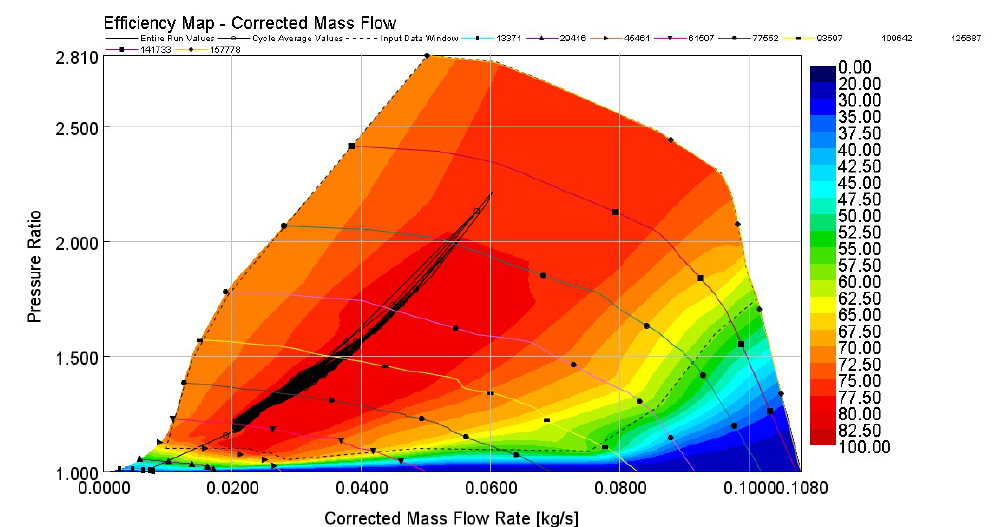
Figure A4. Single stage compressor map for PEMFC application.